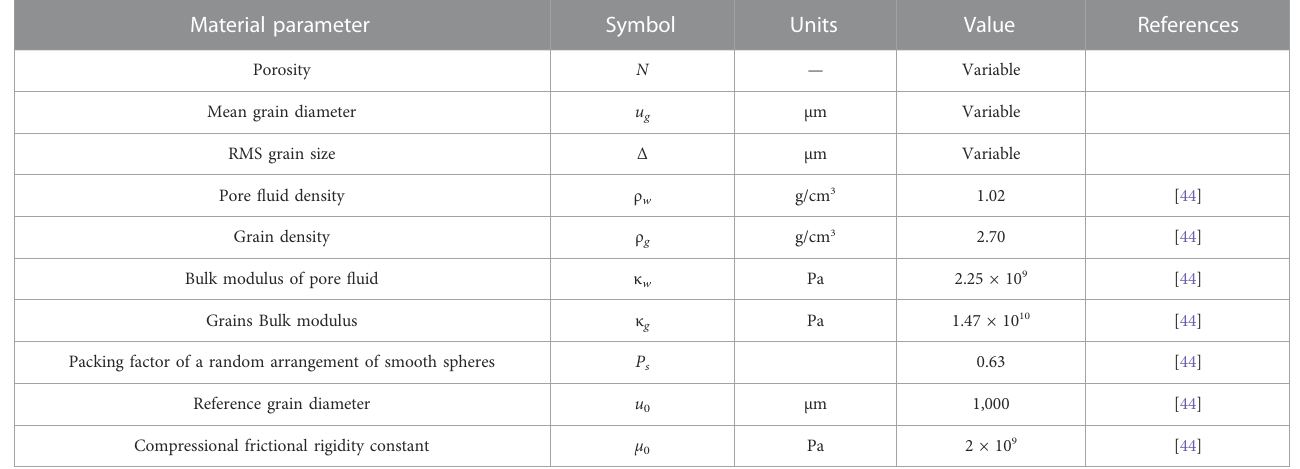
TABLE 2 Parameters in the Wood model, random packing of rough spheres model, and the intergranular friction